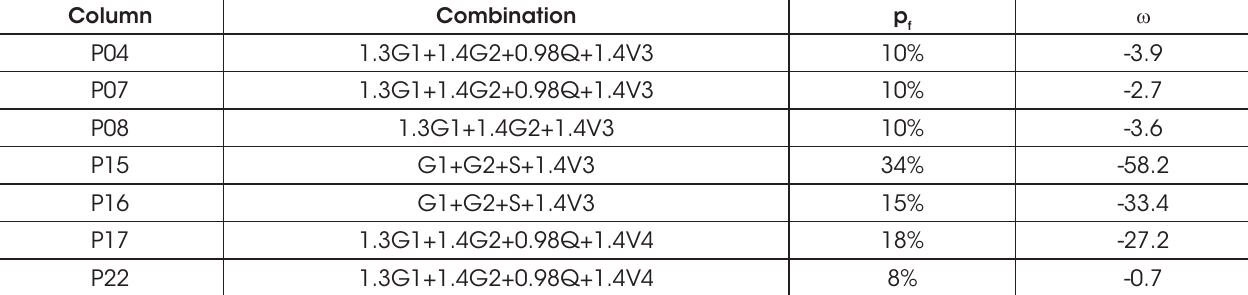
Evaluation of the columns under NBR 6118’s prescriptions